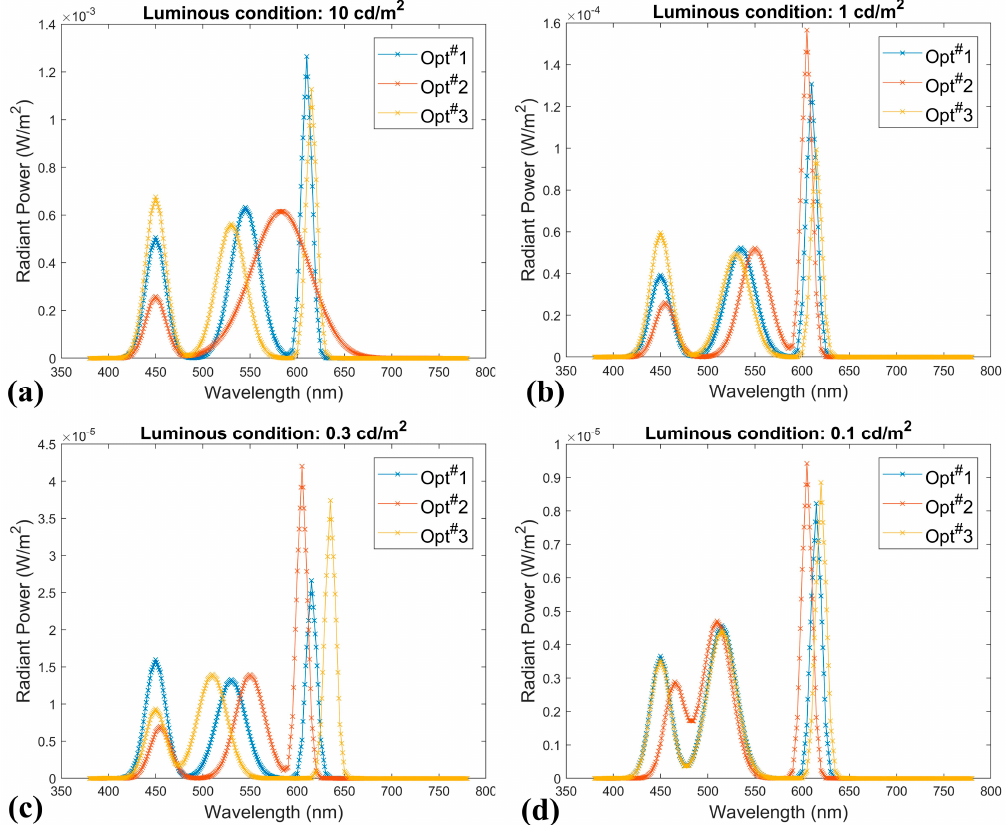
Figure 2. Optimal spectral power distributions (SPDs) for four lighting conditions: ( a ) 10 cd/m 2 , ( b ) 1 cd/m 2 , ( c ) 0.3 cd/m 2 , ( d ) 0.1 cd/m 2.